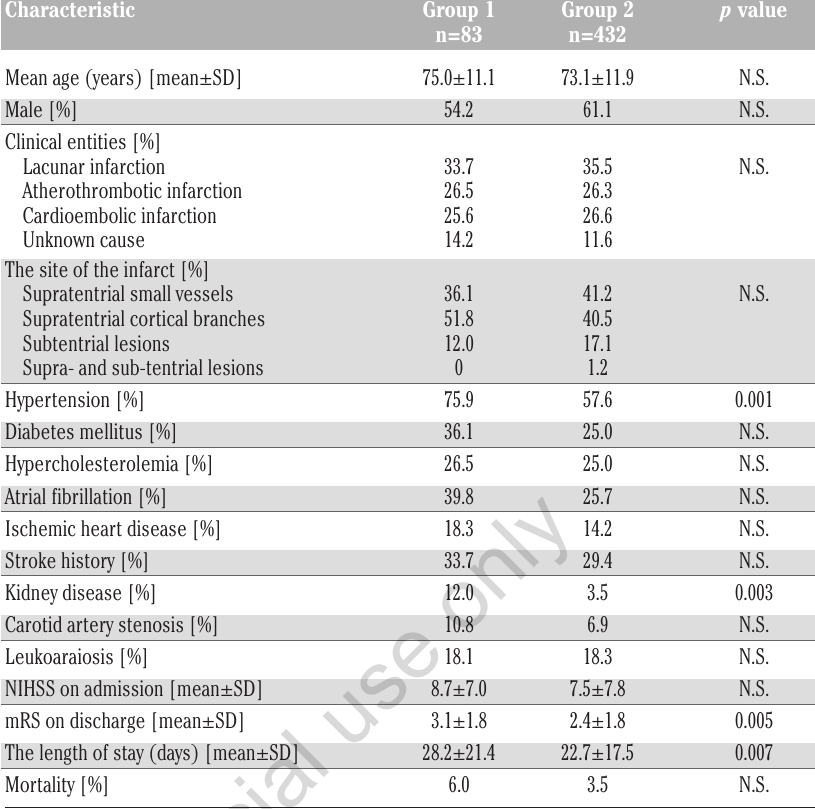
Table 1. Baseline characteristics of subjects.